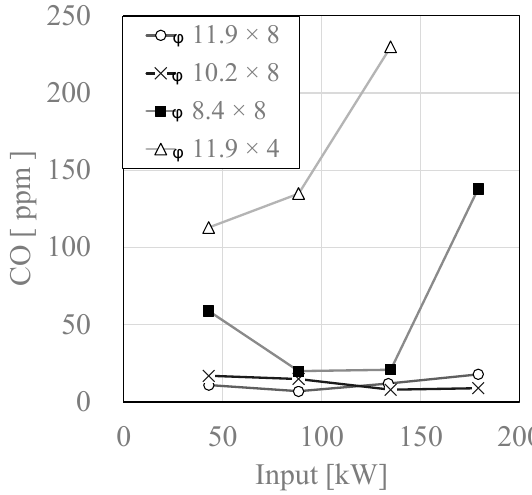
Figure 5. CO emissions characteristics for different combustion rates under each air nozzle case. At 723 K, P = +15 Pa, λ = 1.2 and E H2 =